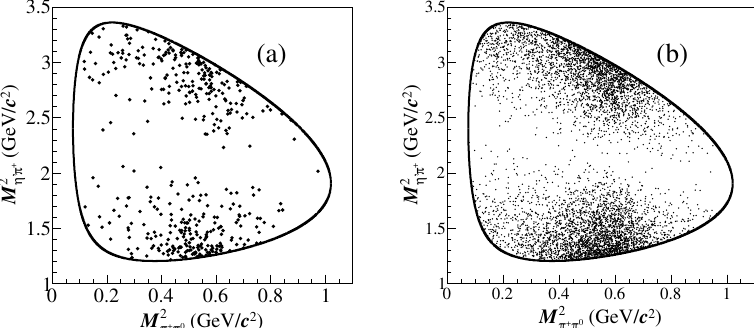
versus m 2 for (a) the data sample and (b) the signal MC η 0 π + π + π 0 √ s = 4 . 178 − 4 . 226 GeV. The